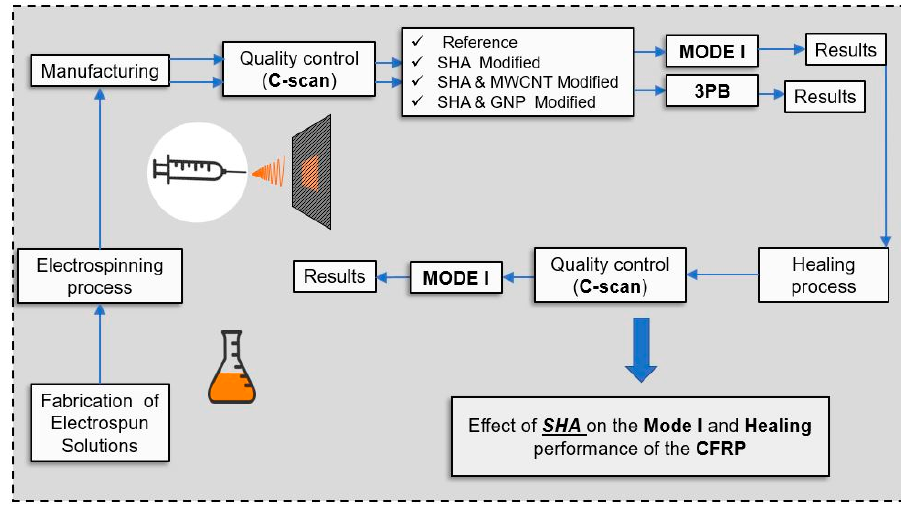
Figure 3. Schematic representation of the steps followed in the current